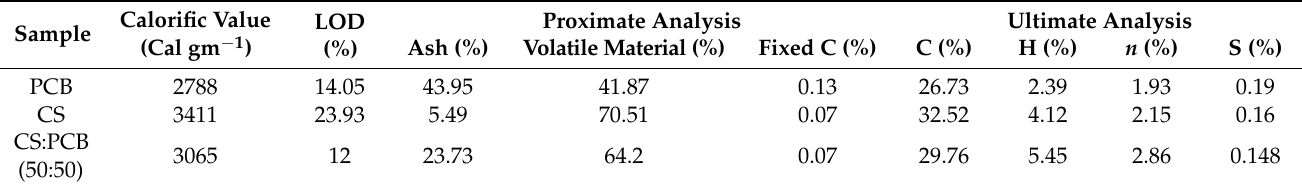
Table 2. Proximate and ultimate analysis of samples.